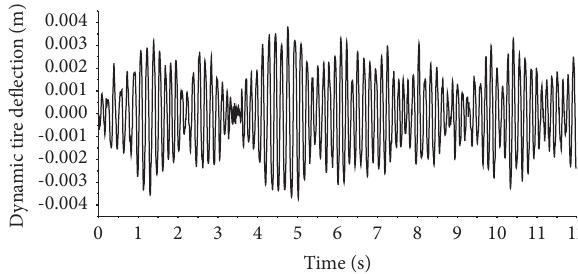
Figure 9: Time-domain plot of the vehicle body